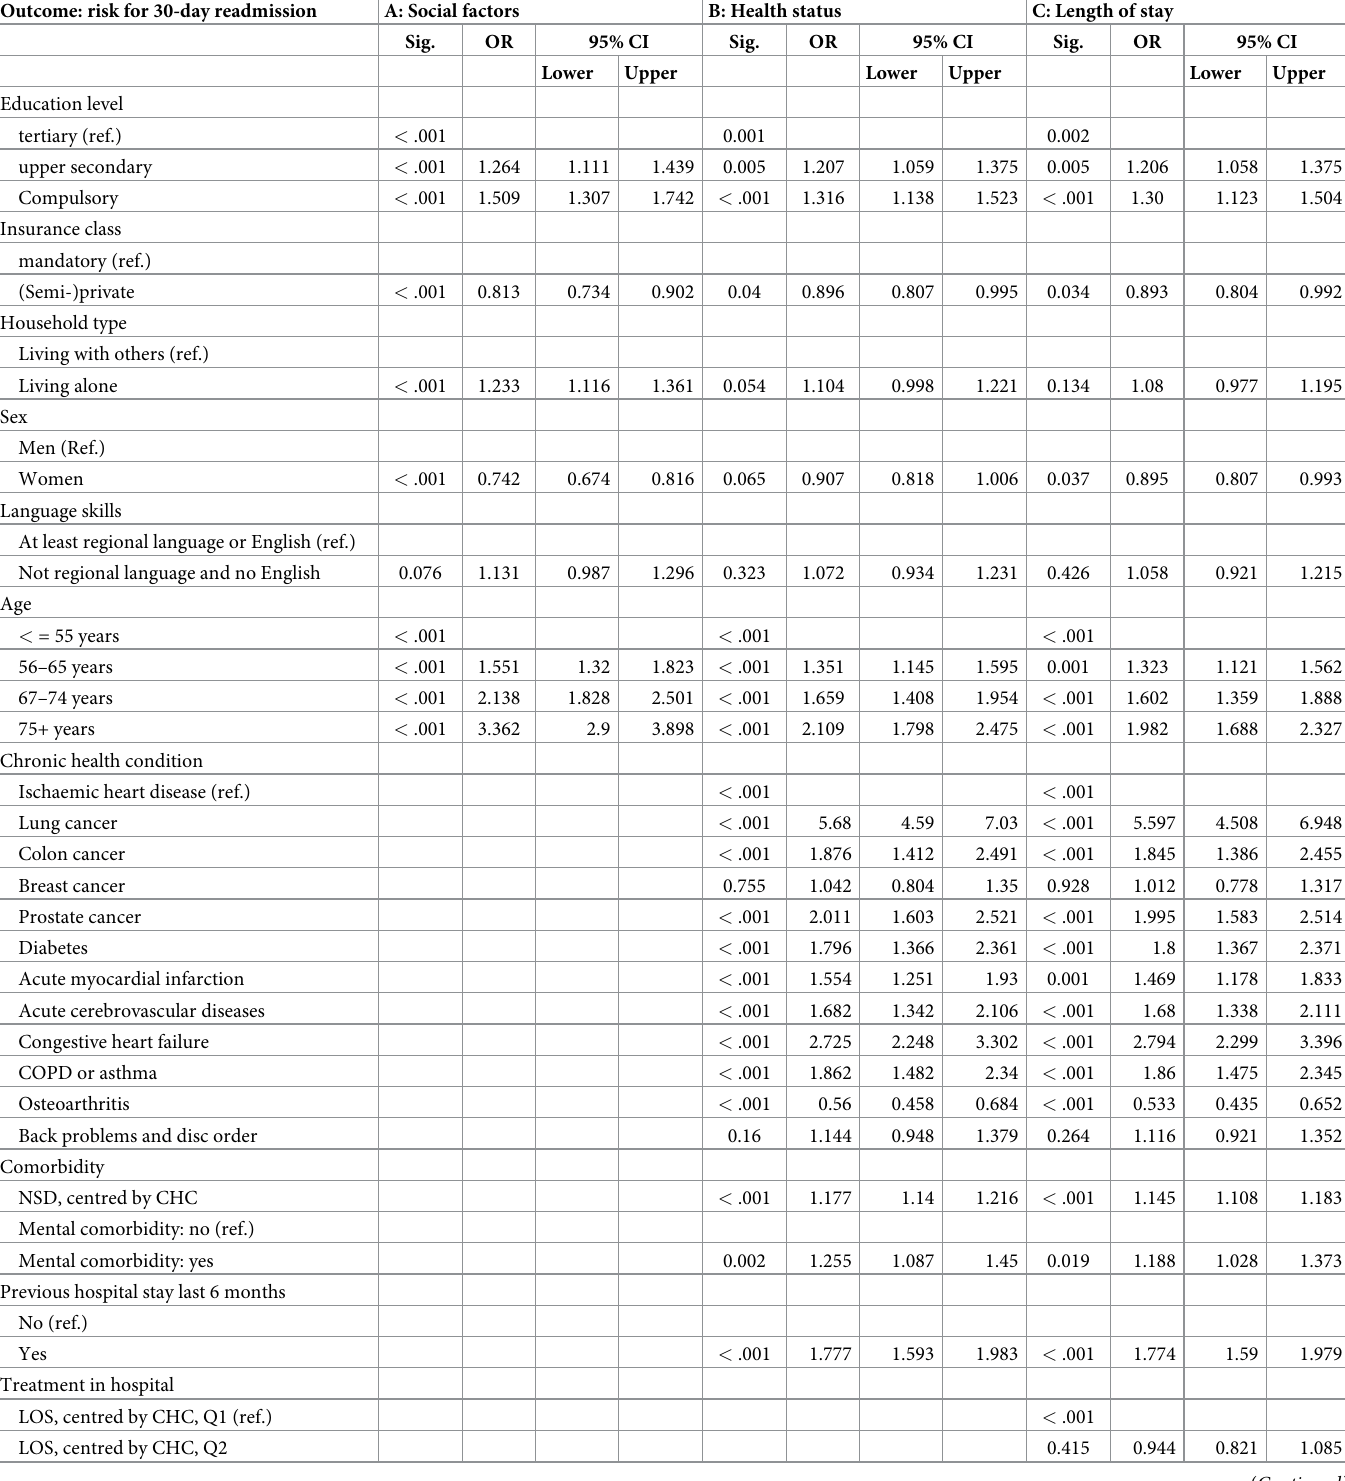
Table 4. Odds ratios of multivariate logistic regression for risk of unplanned 30-day readmission by social factors, health status and length of stay in hospital (N =